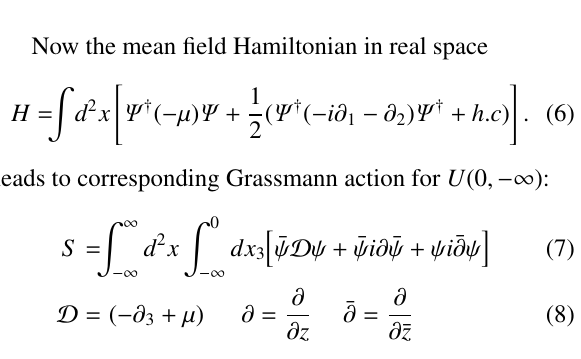
Fig. 2. Euclidean